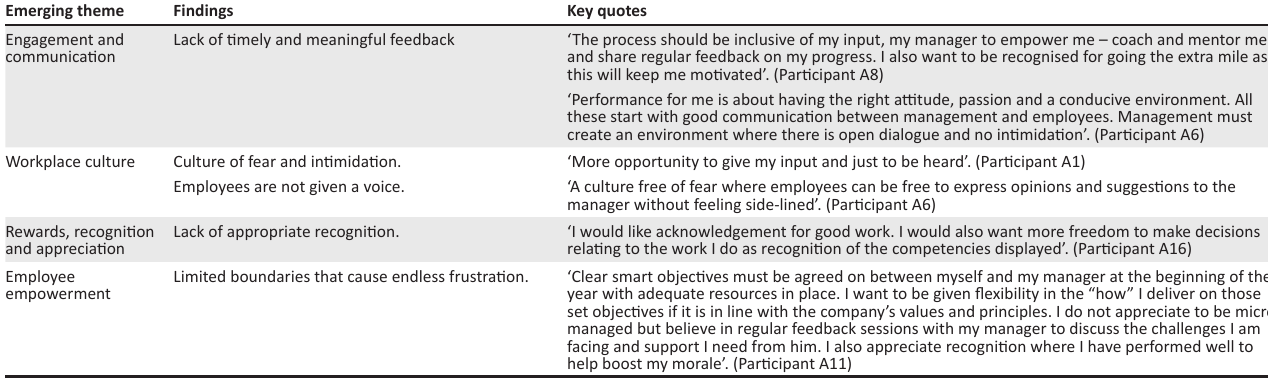
TABLE 3: Summary of findings for question 2 – Performance management. How do you want to be performance managed? Emerging theme Findings